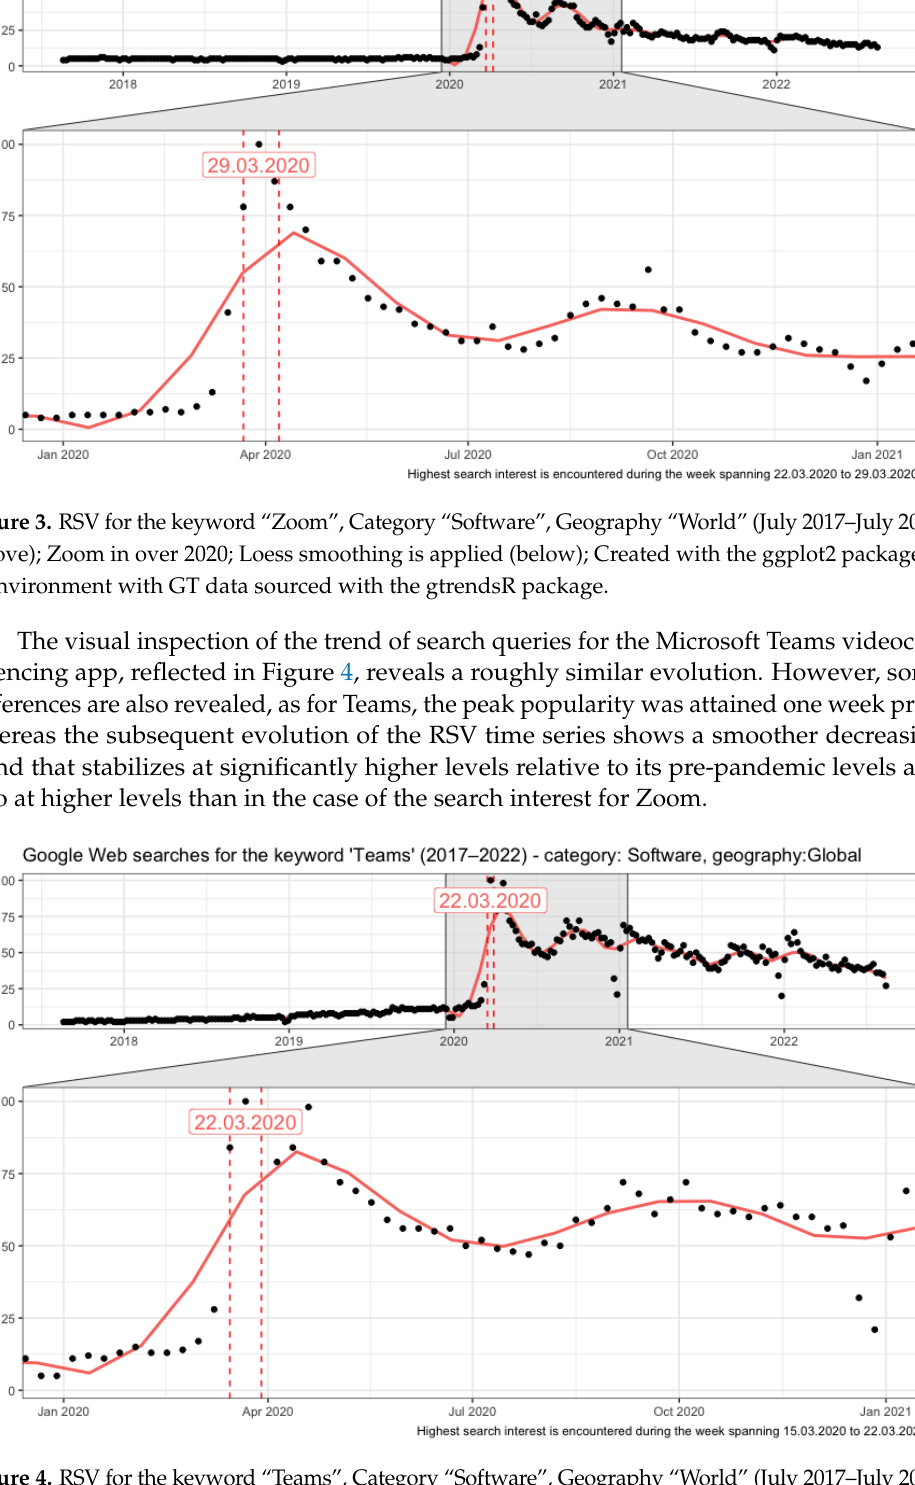
Figure 4. RSV for the keyword “Teams”, Category “Software”, Geography “World” (July 2017 – July 2022) (above); Zoom in over 2020; Loess smoothing is applied (below); Created with the ggplot2 package in R environment with GT data sourced with the gtrendsR package.